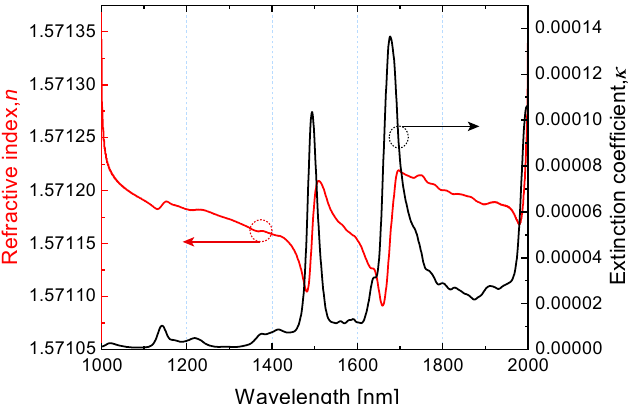
Figure 1. Dispersion characteristic of the N-Methylaniline (NMA) molecules as a function of the wavelength in the